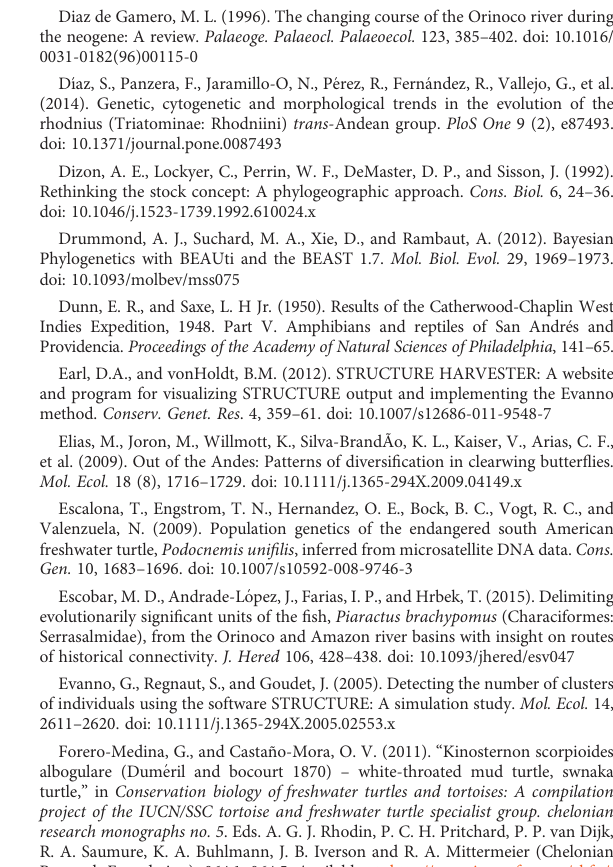
SUPPLEMENTARY FIGURE 4 Assessment about what impact the missing data is having on the population structure analysis in Kinosternon scorpioides from insular (San Andre ́ s) and continental (Caribbean, Orinoco and Amazon) Colombia. (A) Bayesian analysis (STRUCTURE) and Principal Component Analysis using a matrix of 35,507 SNPs across 24 samples, tolerating up to 99% of missing data. (B) Bayesian analysis (STRUCTURE) and Principal Component Analysis using a matrix of 383 SNPs across 23 samples, tolerating up to 10% of missing data. (C) Cladogram re fl ecting the most likely phylogenetic hypothesis of Kinosternon scorpioides from insular (San Andre ́ s) and continental (Caribbean, Orinoco and Amazon) Colombia, which serves as a predictive guide to the most likely coancestry patterns expected in STRUCTURE analyses for (A, B)